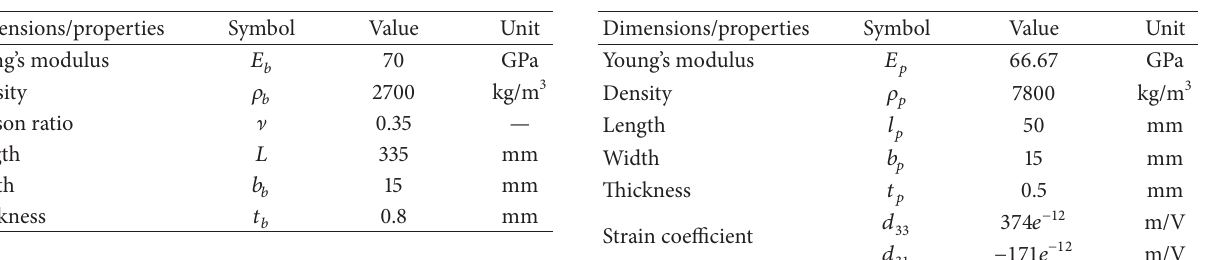
Table 1: Beam’s dimensions and properties. Table 2: Piezoelectric material’s dimensions and